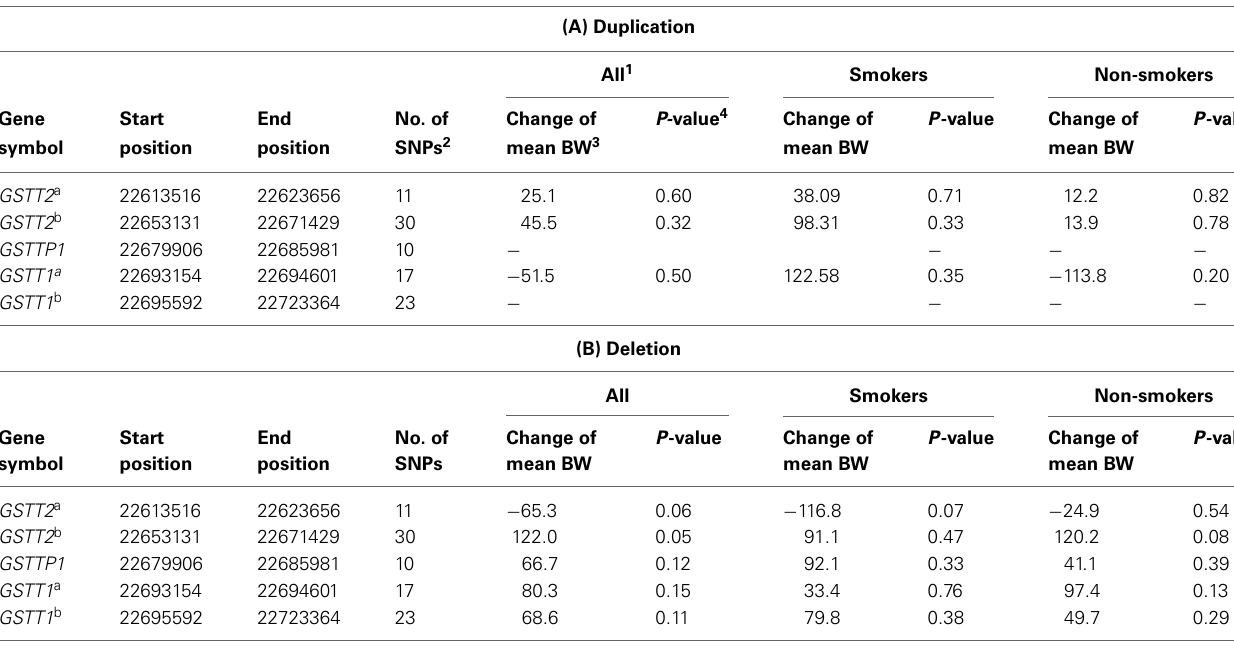
( Table 3B : 120.2 g, p = 0 . 08) in infants of non-smoking moth- ers and is more common in non-smokers ( Table 5 : odds ratio of smoking vs. non-smoking = 0.68, p = 0 . 20), but again the